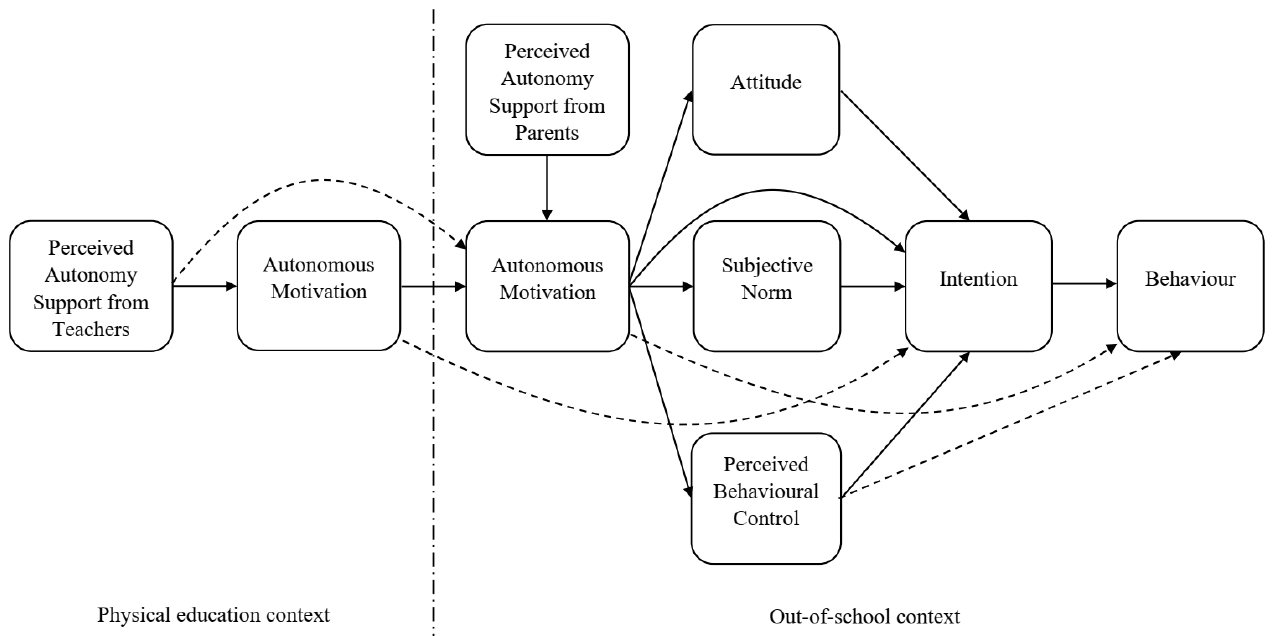
Figure 1. The trans-contextual model of motivation (TCM) expanded by parental autonomy support. Adapted with permission from ref. [24]. 2022 Taylor & Francis.